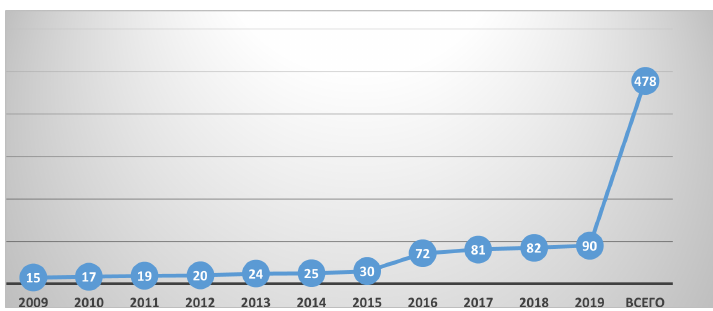
Figure 4. Dynamics of admission of victims with concomitant injury